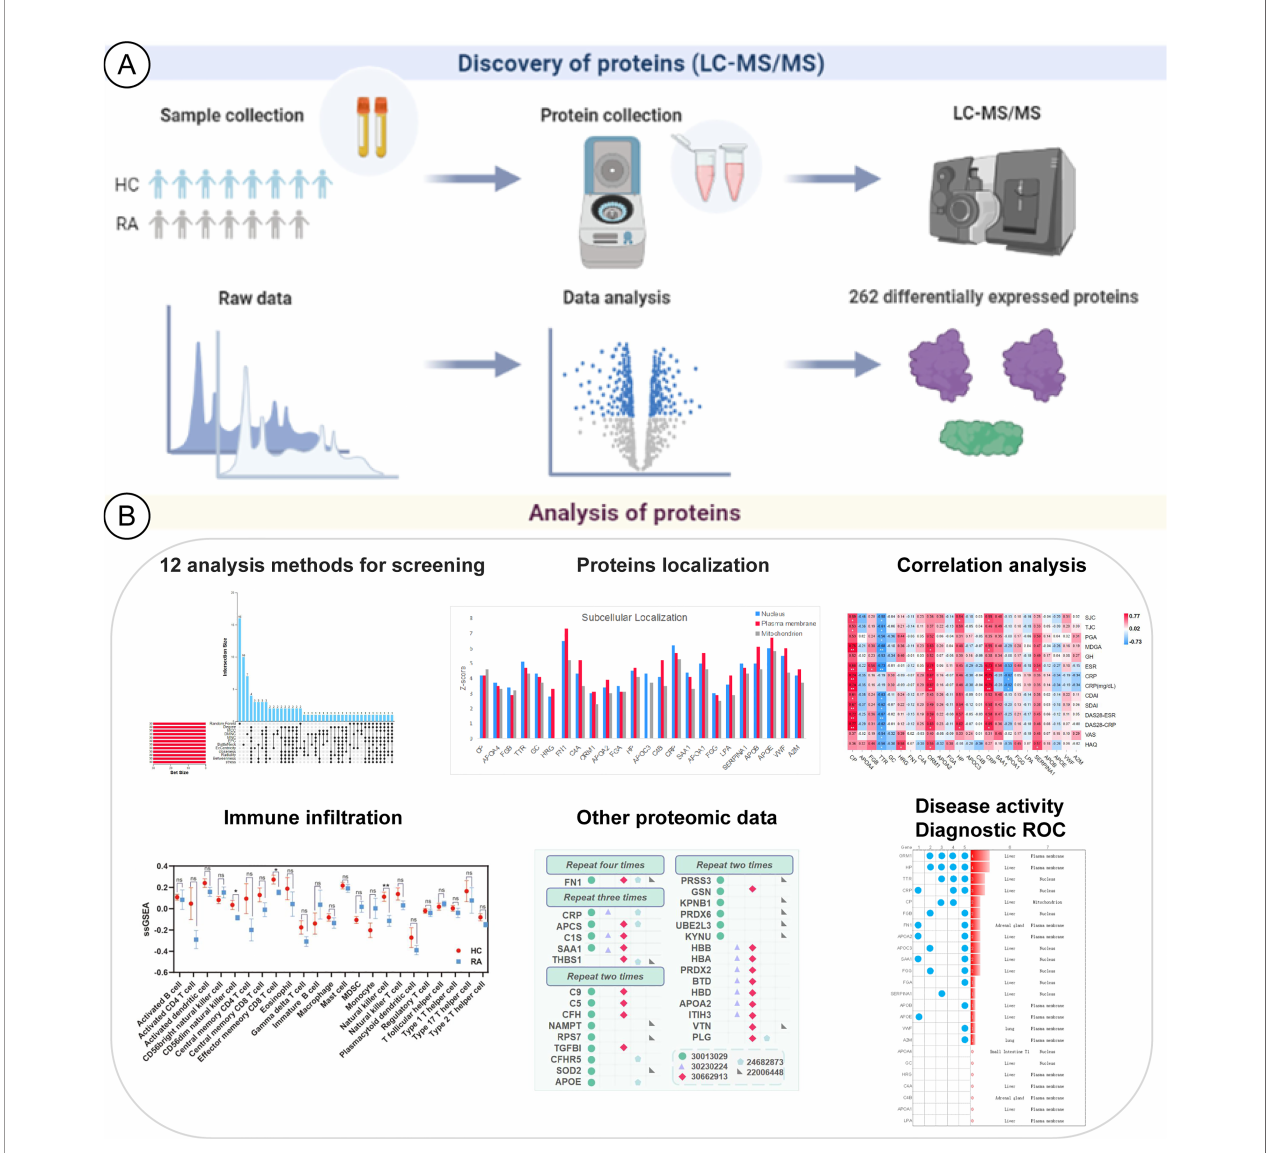
FIGURE 1 | Schematic diagram about the analysis of RA potential proteins based on LC-MS proteomics. (A) Identi fi cation of differentially expressed proteins. (B) Multiple-analysis methods to assess the importance of differentially expressed